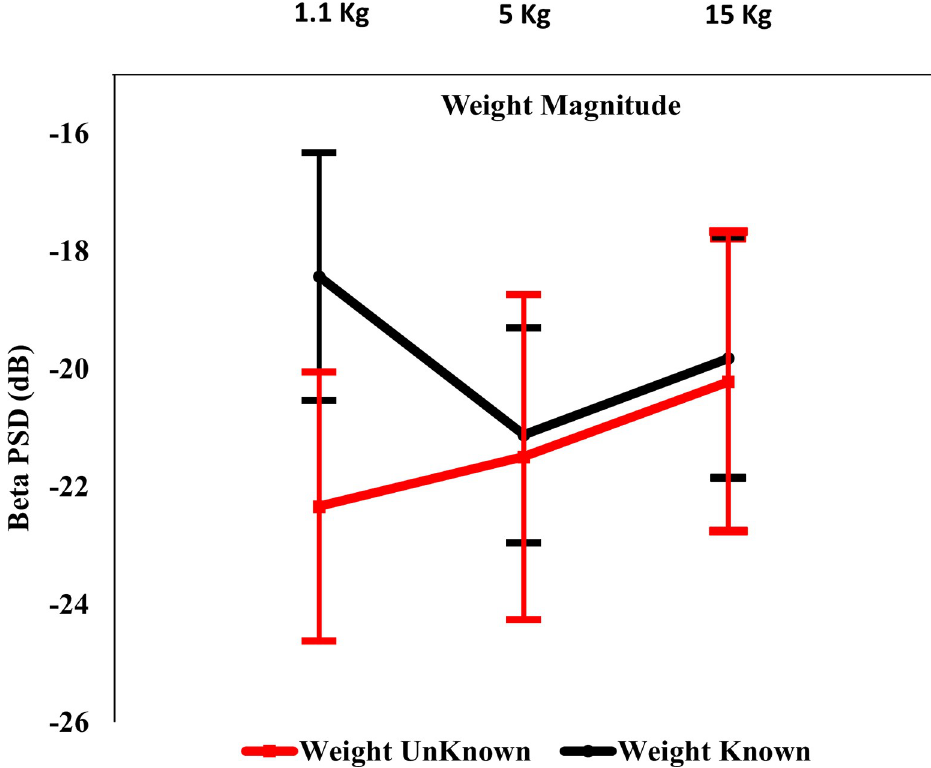
Fig 3. Effects of weight knowledge and weight magnitude on parietal region β band PSD. https://doi.org/10.1371/journal.pone.0247442.g003 of both the frontal and central regions of the brain [frontal: F(1,9) = 9.64, p < 0.013, η 2 = 0.52, and central: F(1,9) = 6.004, p < 0.037, η 2 = 0.4], where lifting unknown weights was associated